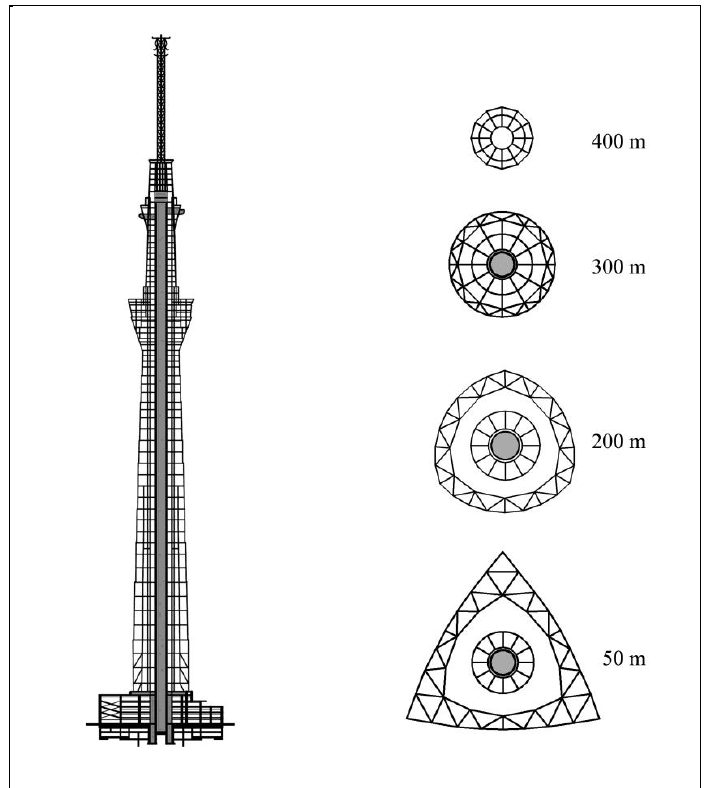
Figure 16. Tokyo Sky Tree: Structural outline (developed by authors on the basis of [44]).